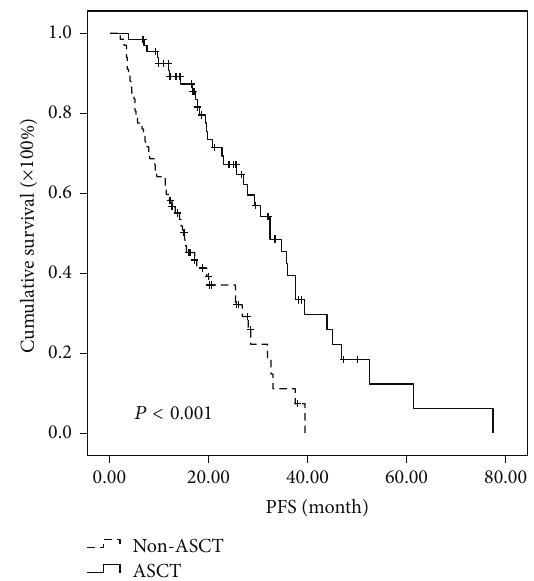
Figure 1: Comparison of PFS in the patients of ASCT group and non-ASCT group regardless of risk stratification. The median PFS was prolonged 17.3 months in ASCT group (32.4 versus 15.1 months, 𝑃 < 0.001 ).